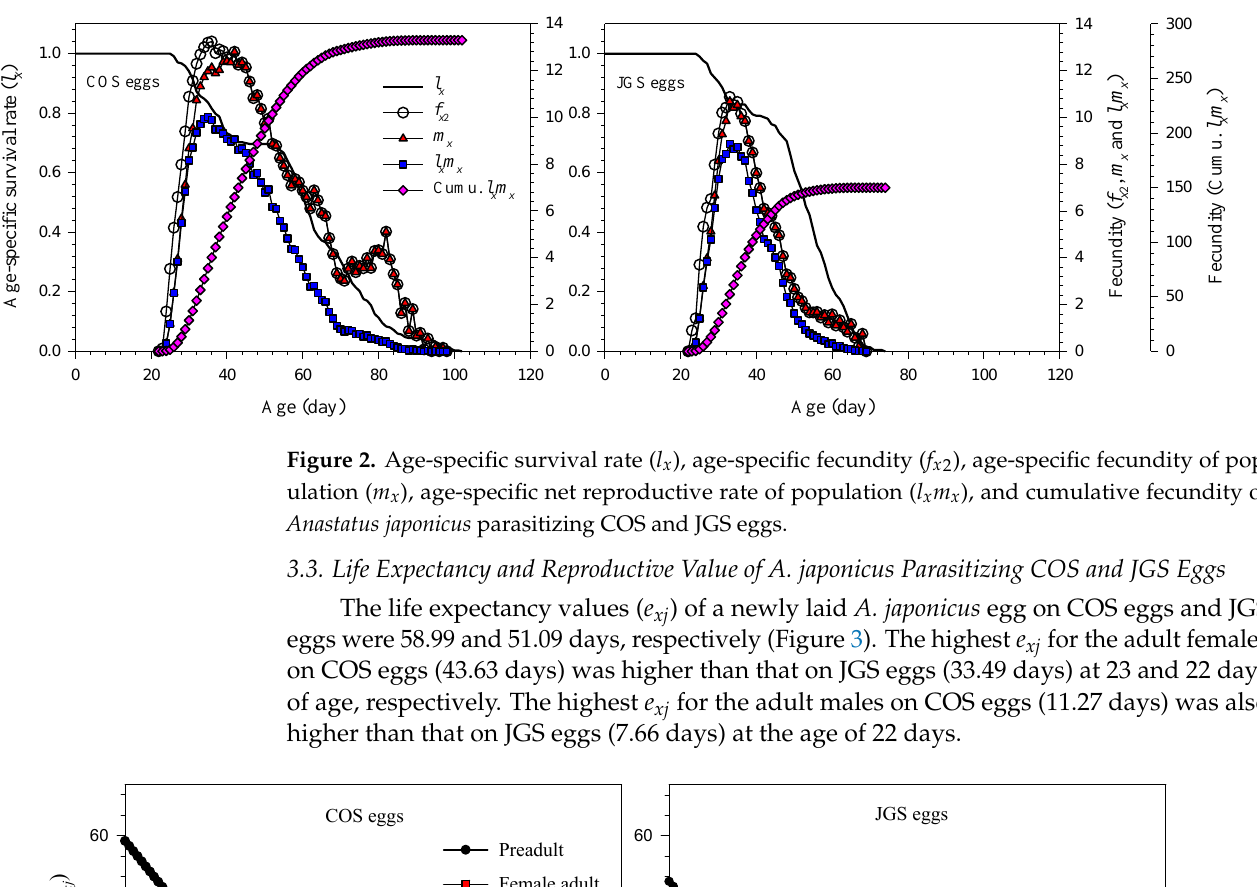
Figure 1. Age-stage survival rate ( s xj ) of Anastatus japonicus parasitizing COS and JGS eggs. The age-specific survival rate ( l x ), age-specific fecundity ( f x 2 ), age-specific fecundity of population ( m x ), and age-specific net reproductive rate ( l x m x ) of A. japonicus parasitizing COS eggs and JGS eggs were illustrated on Figure 2. The l x was higher on the JGS than COS eggs from 36 to 47 days of age. The highest m x was 12.80 at the age of 42 days on the COS eggs or 10.54 at the age of 35 days on the JGS eggs. Both the m x and l x m x decreased gradually on COS and JGS eggs (after 42 and 35 days old, respectively), except that the m x increased again from 79 to 82 days of age and then decreased again on the COS eggs. The ages at which adult females reached 90% cumulative fecundity on COS eggs (256.45) and JGS eggs (135.03) were 61 and 47 days, respectively.